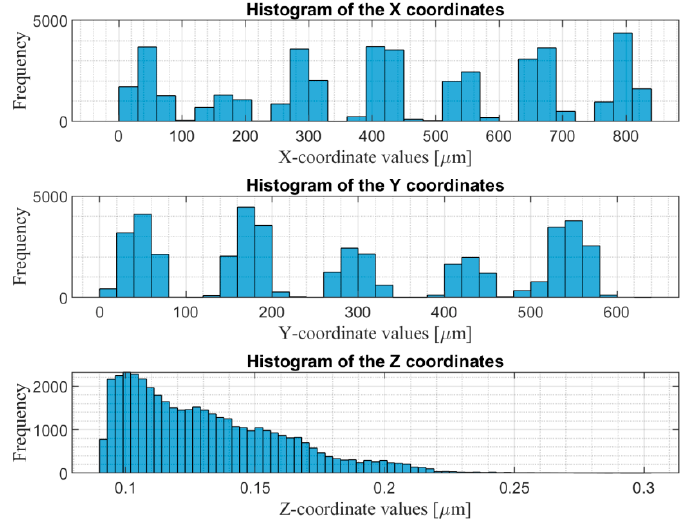
Figure 16. Separation of the cylinders: ( a ) The separated cylinders from the base and ( b ) separate cylinders into individual clusters.